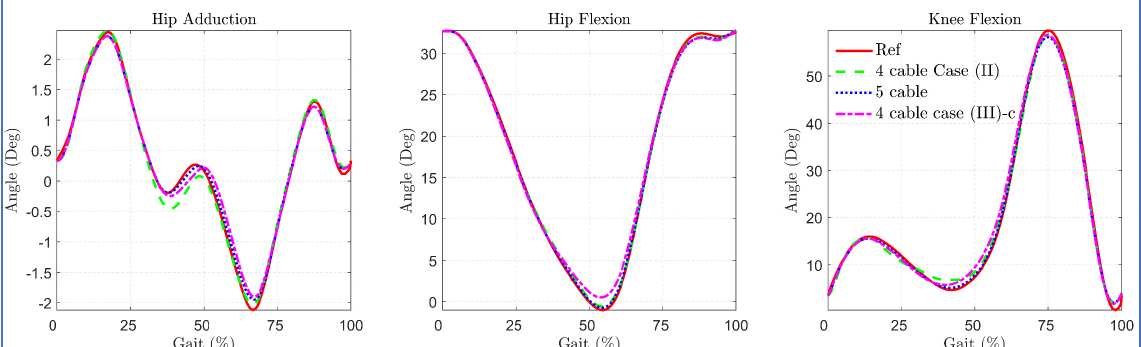
Figure 13. Tracking errors in 4 cables versus 5 cables routing.